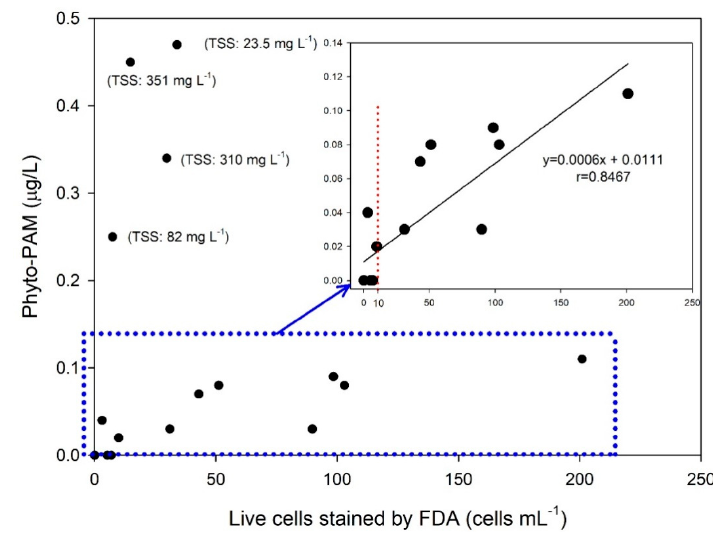
Figure 4. Correlation between live cells stained by FDA and Phyto-PAM values in the shipboard